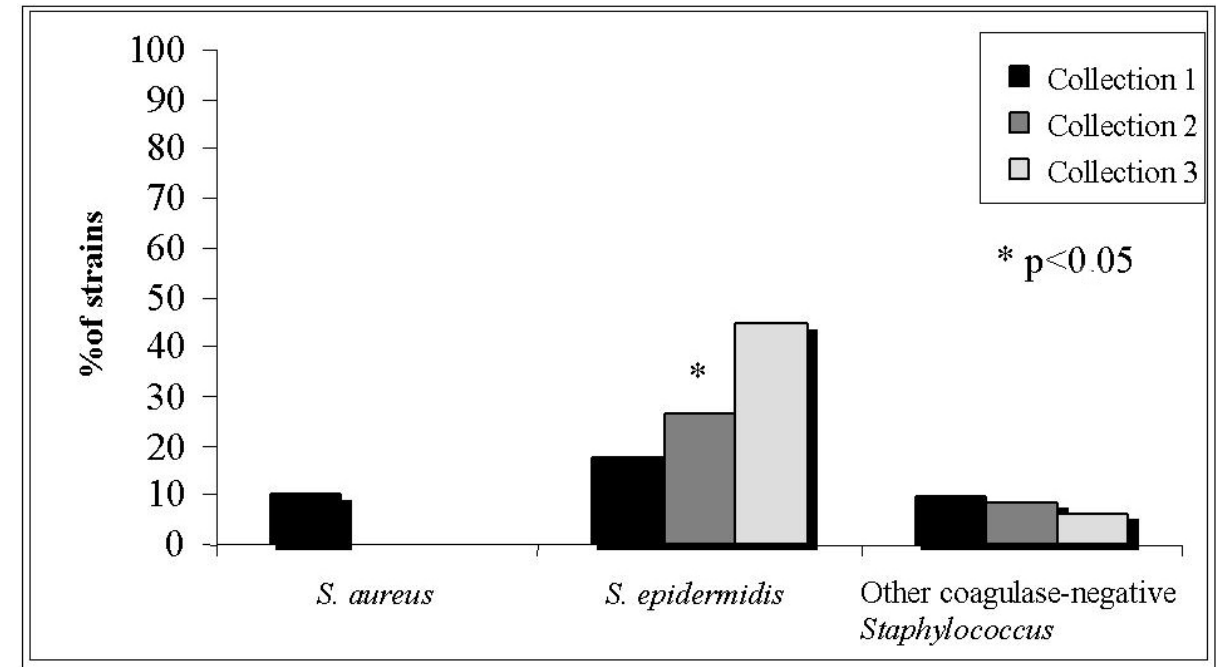
Figure 1. In vitro resistance profile of S. aureus , S. epidermidis and other CNS strains to oxacillin in three sample collections from 32 patients subjected to peritoneal dialysis at